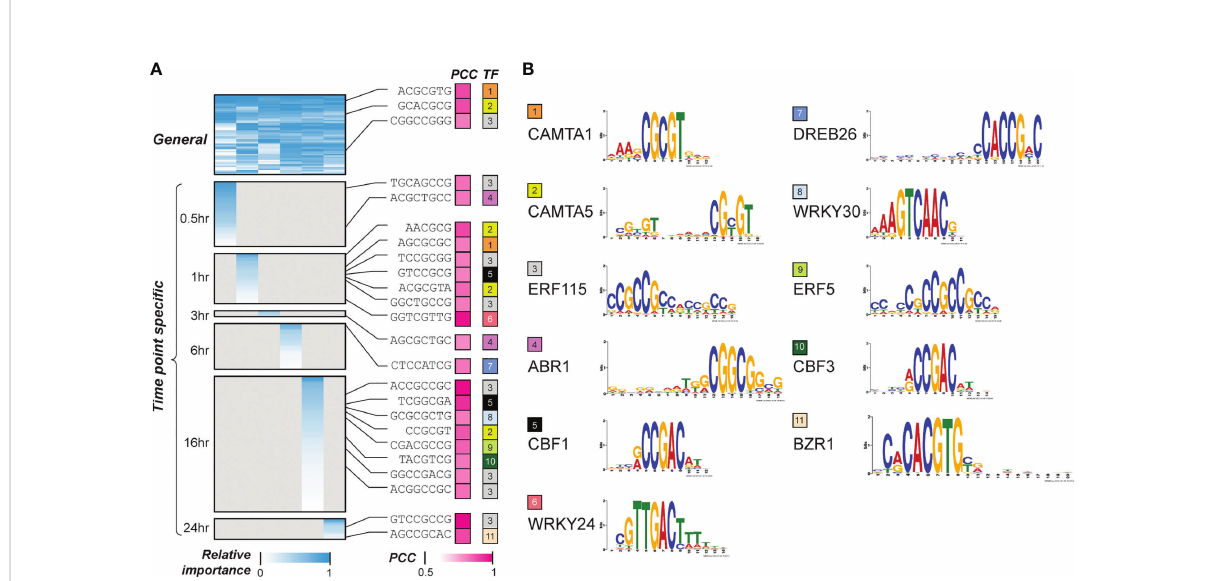
FIGURE 2 Interpretation of the temporal cold-responsiveness prediction models. (A) General and time point-speci fi c pCREs and their similarities to known cold responsive CREs. Heatmap in the left panel shows the relative importance of pCREs, short sequences in the middle indicate pCREs that are similar to CREs known to regulate cold response (cold-TFBMs), which are shown in the right panel. Color scale in blue represents min-max scaled Gini index calculated for features in a time point model; color scale in pink indicates similarities between pCREs and cold-TFBMs. (B) Transcription factors (TFs) that bind to the cold-TFBMs are shown with different colors, and the sequence logos of TF binding sites are shown in the rightmost panel. PCC, pearson correlation coef fi cient; TFBM, transcription factor binding